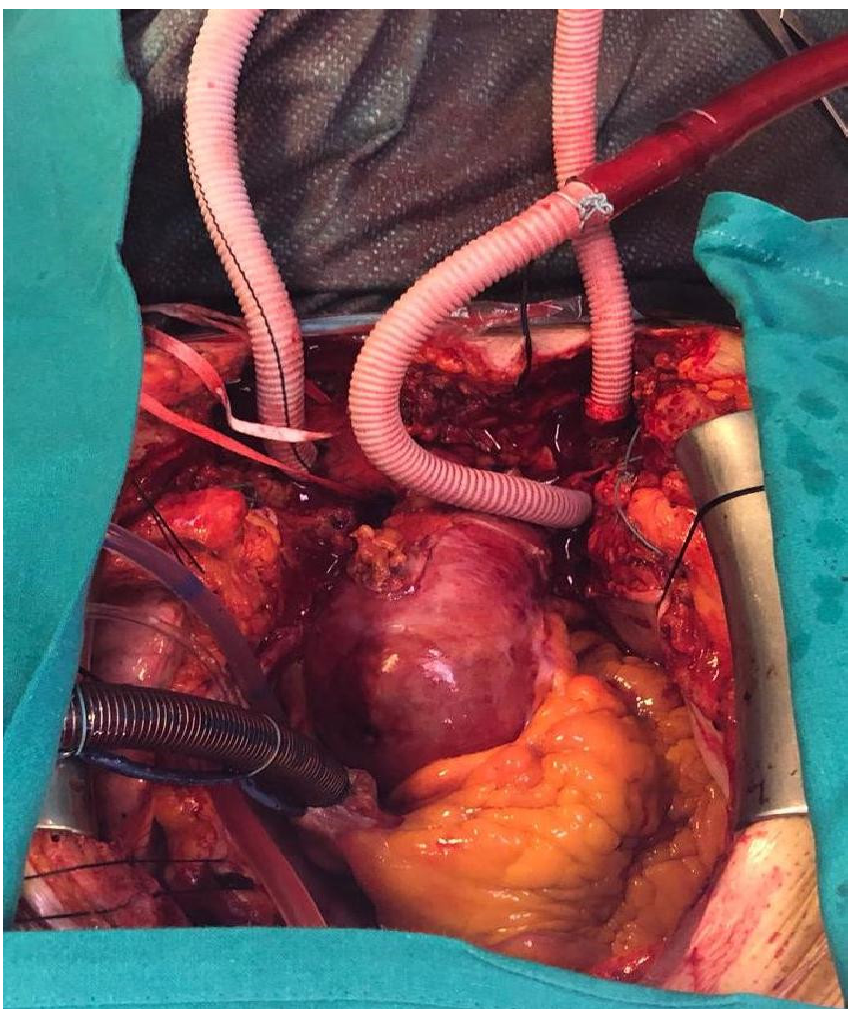
Figure 1. Selective cannulation of intrathoracic right subclavian (RSA), left common carotid (LCA), and left subclavian arteries (LSA) with interposition of an end-to-side dacron vascular graft.